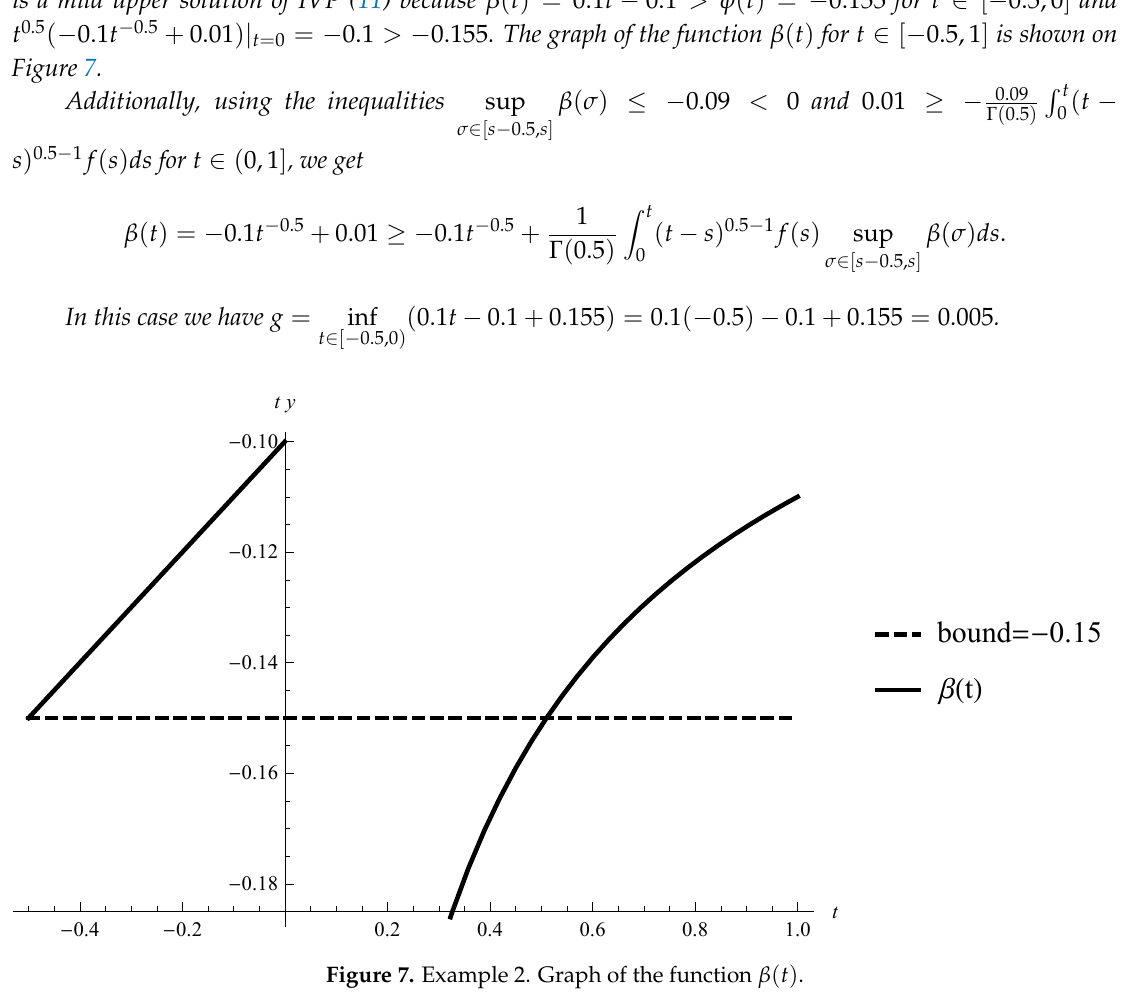
Figure 7. Example 2. Graph of the function β ( t )